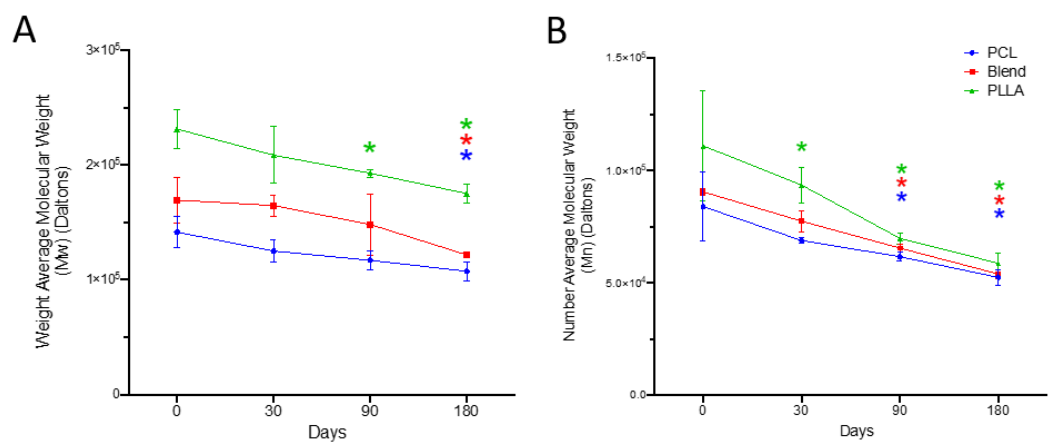
Figure 4. Molecular weight changes for PCL, 50:50 PCL:PLLA blend and PLLA electrospun fibres following storage in phosphate buffered saline at 37 °C for 30, 90 and 180 days and measured using gel permeation chromatography in terms of ( A ) weight average molecular weight (Mw) and ( B ) number average molecular number (Mn). Statistical comparison performed with two-way ANOVA and Dunnett’s multiple comparisons test (* p < 0.05; n = 5). Stars (*) represent statistical significance compared to non-degraded scaffold (time zero).